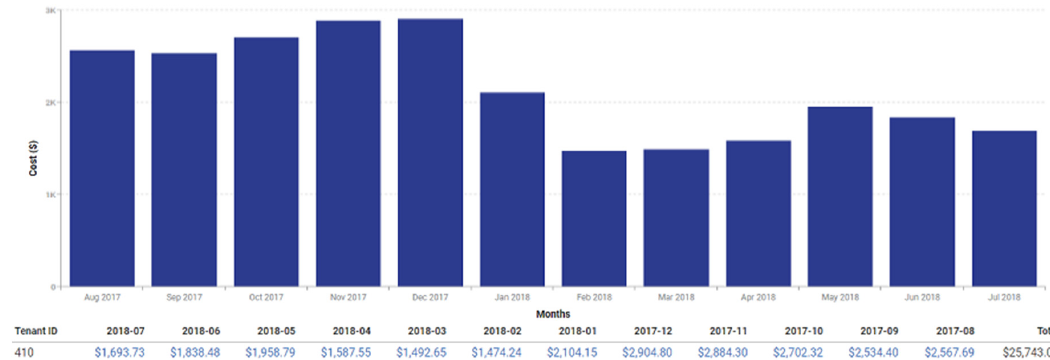
Figure 9. AWS prices statistics by months for the whole GCC of a customer.